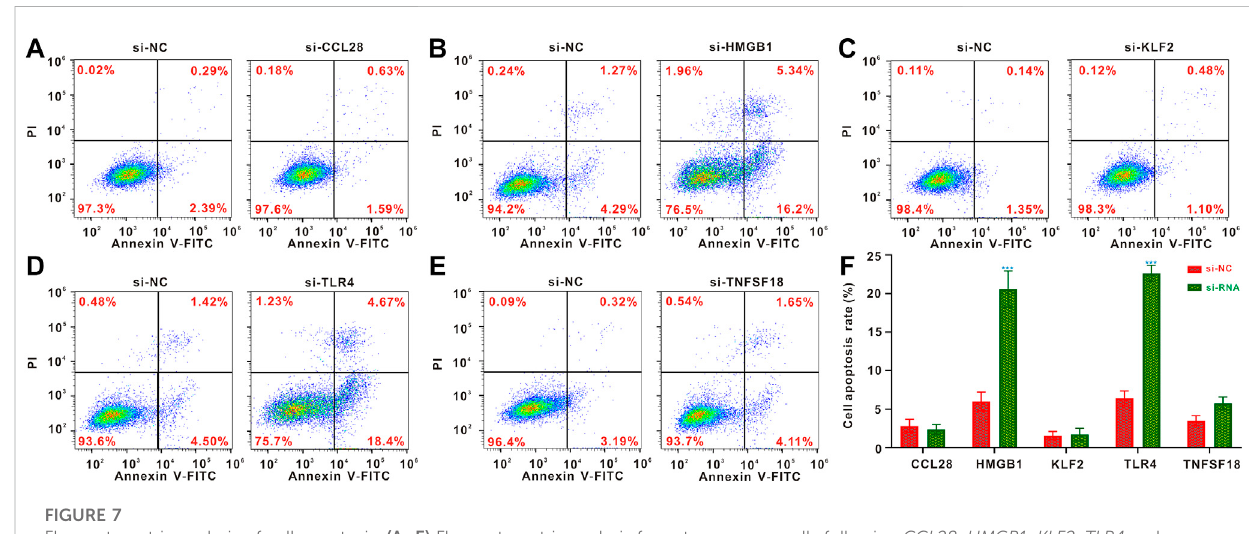
FIGURE 7 Flow cytometric analysis of cell apoptosis. (A – E) Flow cytometric analysis for osteosarcoma cells following CCL28 , HMGB1 , KLF2 , TLR4 and TNFSF18 knockout (F) Quanti fi ed results of the fl ow cytometric analysis. * p < 0.05; ** p < 0.01; *** p < 0.001.